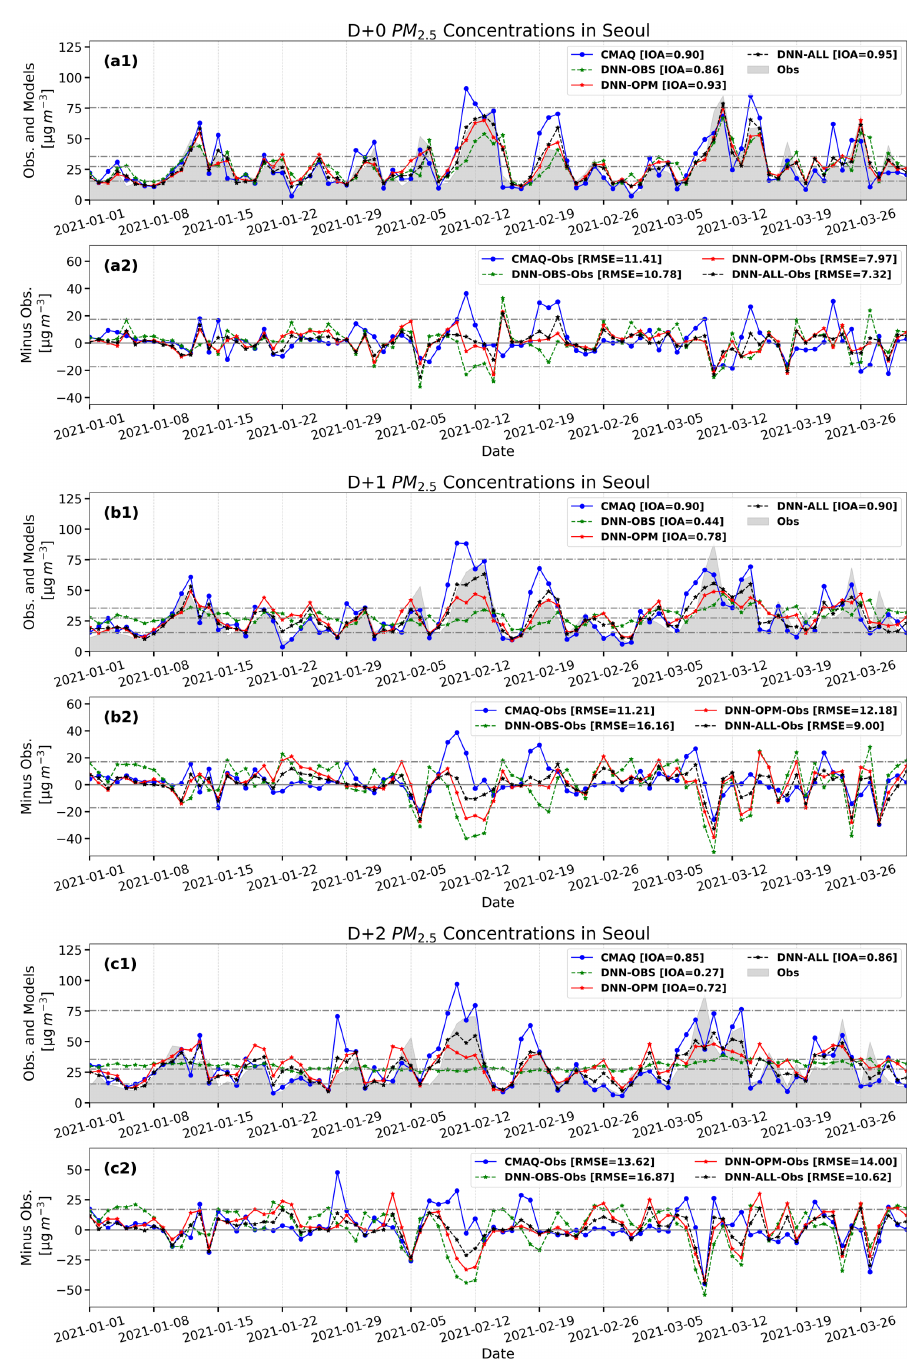
Figure 7. Time series of PM 2 . 5 concentrations from observations and predictions using the CMAQ, DNN-OBS, DNN-OPM, and DNN-ALL models. Panels (a1) – (c1) depict the time series of predictions and observations and (a2) – (c2) depict the differences between the predictions and observations (predictions minus observations). In (a1) – (c1) , each of the dashed lines represents values of 15.5, 35.5, 75.5, and the average value of observation (27µgm − 3 ). In (a2) – (c2) , the dashed lines represent the standard deviation of observation PM 2 . 5 as negative and